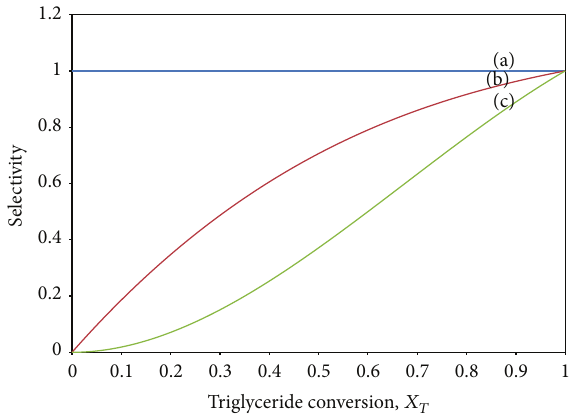
Figure 8: Selectivity of methyl ester at various catalyst concentra- tions, constant temperature of 30 ∘ C, and molar ratio 9: 1 for Case 1.